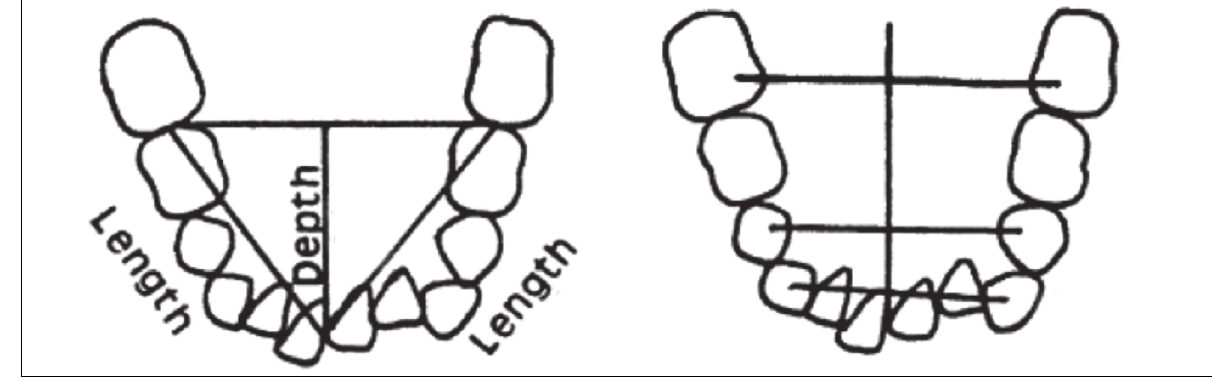
Figure 2. Various arch-dimensional measurements used in this study (Table II).